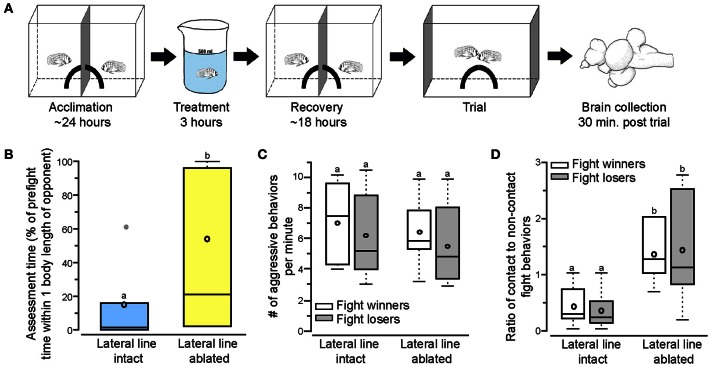
Lateral line-ablated animals have decreased assessment abilities and prefer contact over non-contact fight behaviors. (A) Two dominant Astatotilapia burtoni males acclimated on either side of an opaque blue barrier for 24 h with a quarter of a terracotta pot to serve as a territory. Fish were treated for 3 h (intact: normal cichlid-system water; ablated: 2mM cobalt chloride in low calcium cichlid-system water) and placed back in the experimental tank to recover for 18 h prior to behavioral testing. Total acclimation time, including treatment, was ~2 days. On the day of the trial, the center barrier was removed and the two quarter pots repositioned to form a single half-pot territory to induce a territorial fight. Opaque barriers were placed on both ends of the tank to block the view of neighboring fish during trials. Animals were sacrificed and brains collected 30 min after the fight concluded. Modified from Butler and Maruska (2015). (B) Lateral line-ablated fish (yellow) had increased assessment time (quantified as the percent of pre-fight time spent within one body length of the opponent without performing an aggressive behavior) than lateral line-intact fish (blue). (C) The number of aggressive behaviors per minute was not different between lateral line-intact and lateral line-ablated fight winners and losers. (D) Lateral line-ablated fish used more contact than non-contact fight behaviors (>1 signifies reliance on contact behaviors, < 1 signifies preference for non-contact behaviors). Different letters indicate statistical significance at P < 0.05. Tukey's box plots were used to represent behavior data (N = 6 per group): data median is represented by a line and data mean by an open circle, the box extends to the furthest data points within the 25th and 75th percentile, and whiskers extend to the furthest data points in the 25th/75th percentiles. Absence of whiskers indicates absence of data points outside of the 25th/75th percentiles. Data points outside the 25th/75th percentiles are represented by closed gray circles.